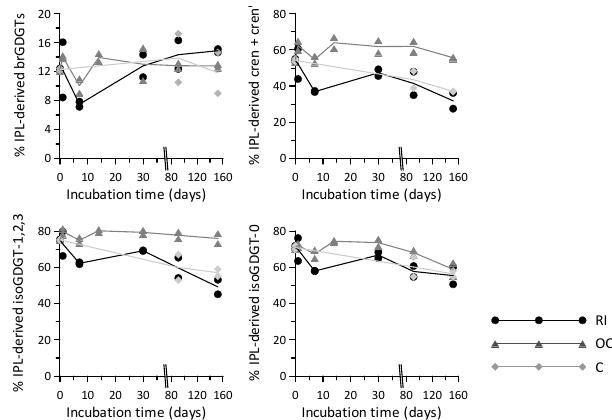
Figure 5. Percentages of the total pool of (a) brGDGTs, (b) crenar- chaeol + cren (cid:48) , (c) isoGDGTs-1,2,3, and (d) isoGDGT-0 present in “living”, or intact polar lipid (IPL)-derived form. Average concen- trations are indicated by solid